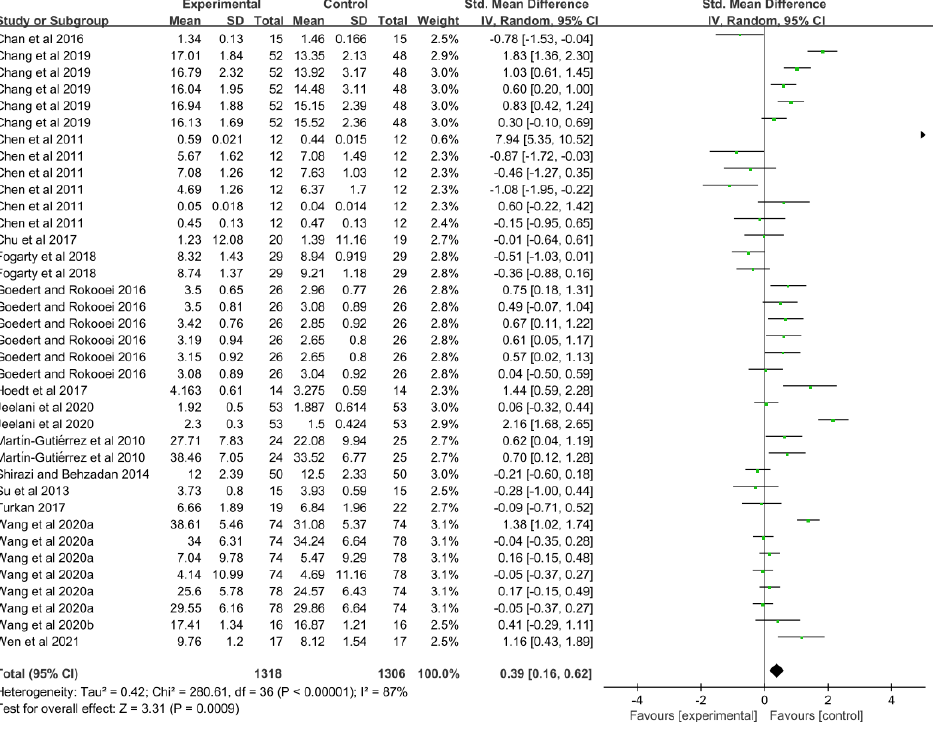
Figure 13. Forest